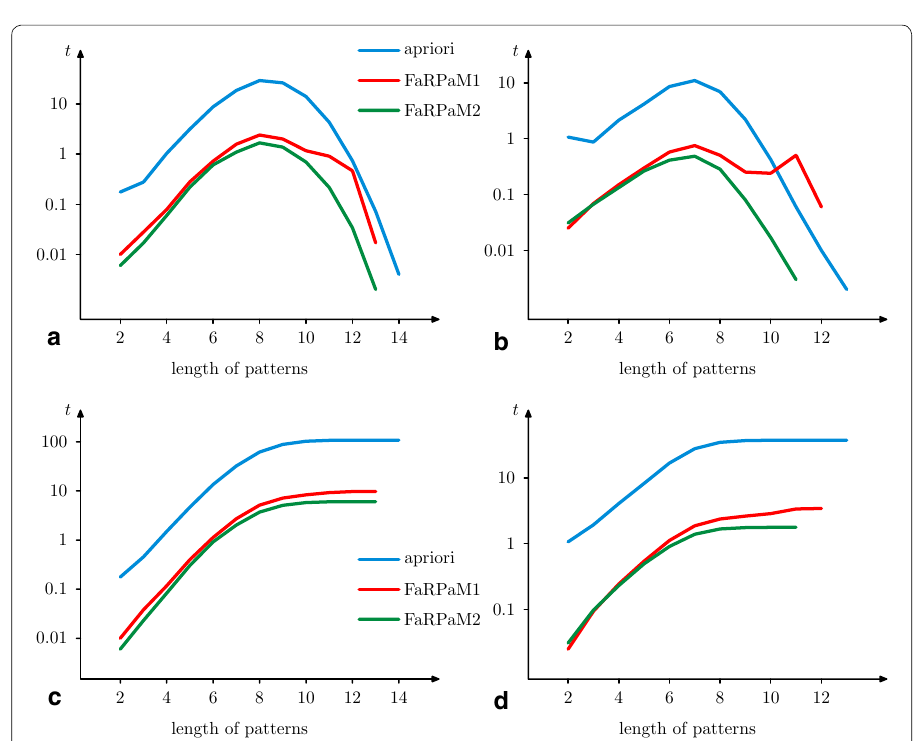
Fig. 8 Time to find all patterns of a given length for different numerical algorithms. a , c Expensive care, b , d non-expensive care; a , b time to find all patterns of a given length, c , d time to find all patterns less or equal a given